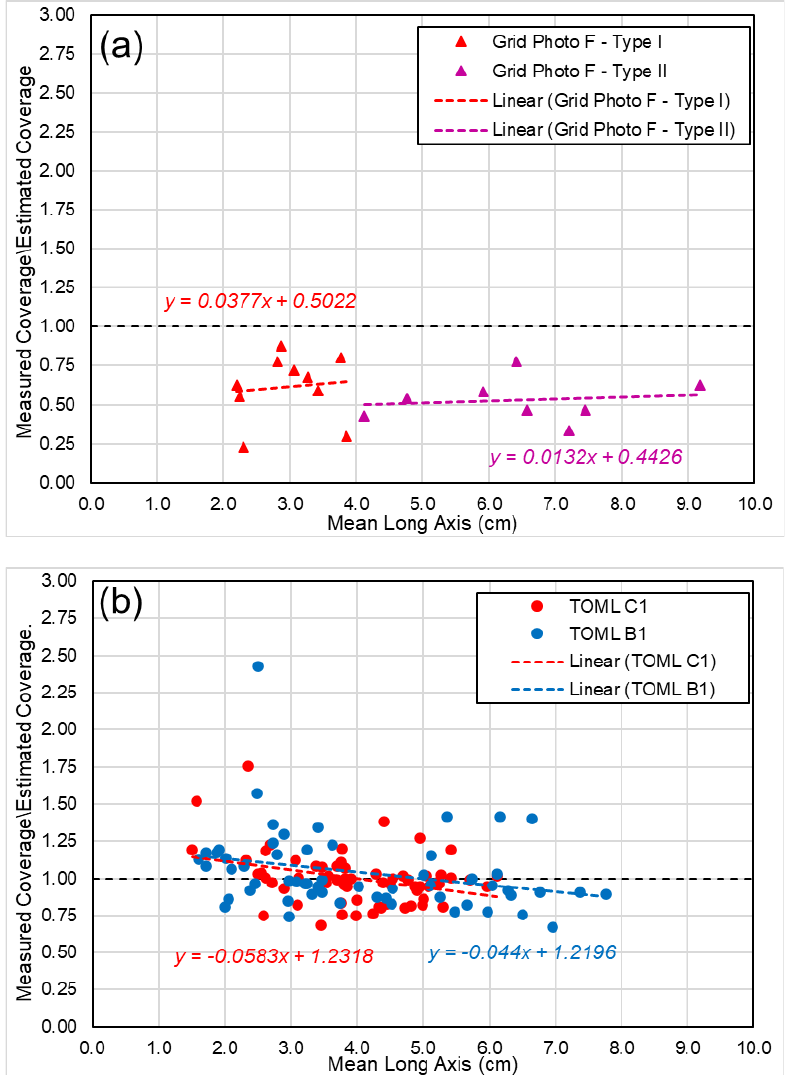
Figure 13. Comparisons of the measured Percentage Coverage and the predicted ones by the new empirical method for Datasets 2 in ( a ) and Dataset 3 in ( b ) with predictions by empirical formula Equation (15).